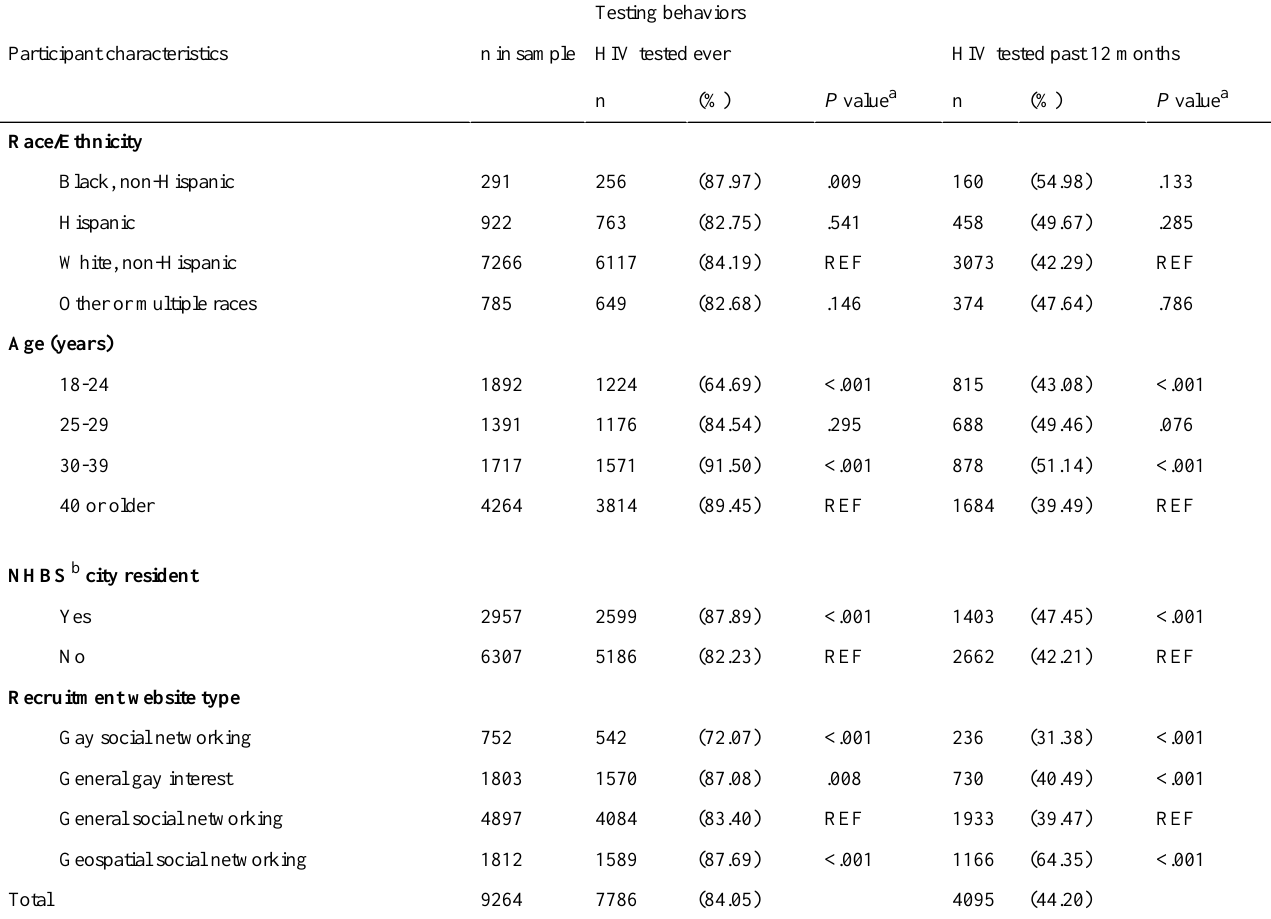
Table 5. HIV testing behaviors of HIV-negative or unknown status MSM participants in the American Men's Internet Survey, United States, 2013. Testing